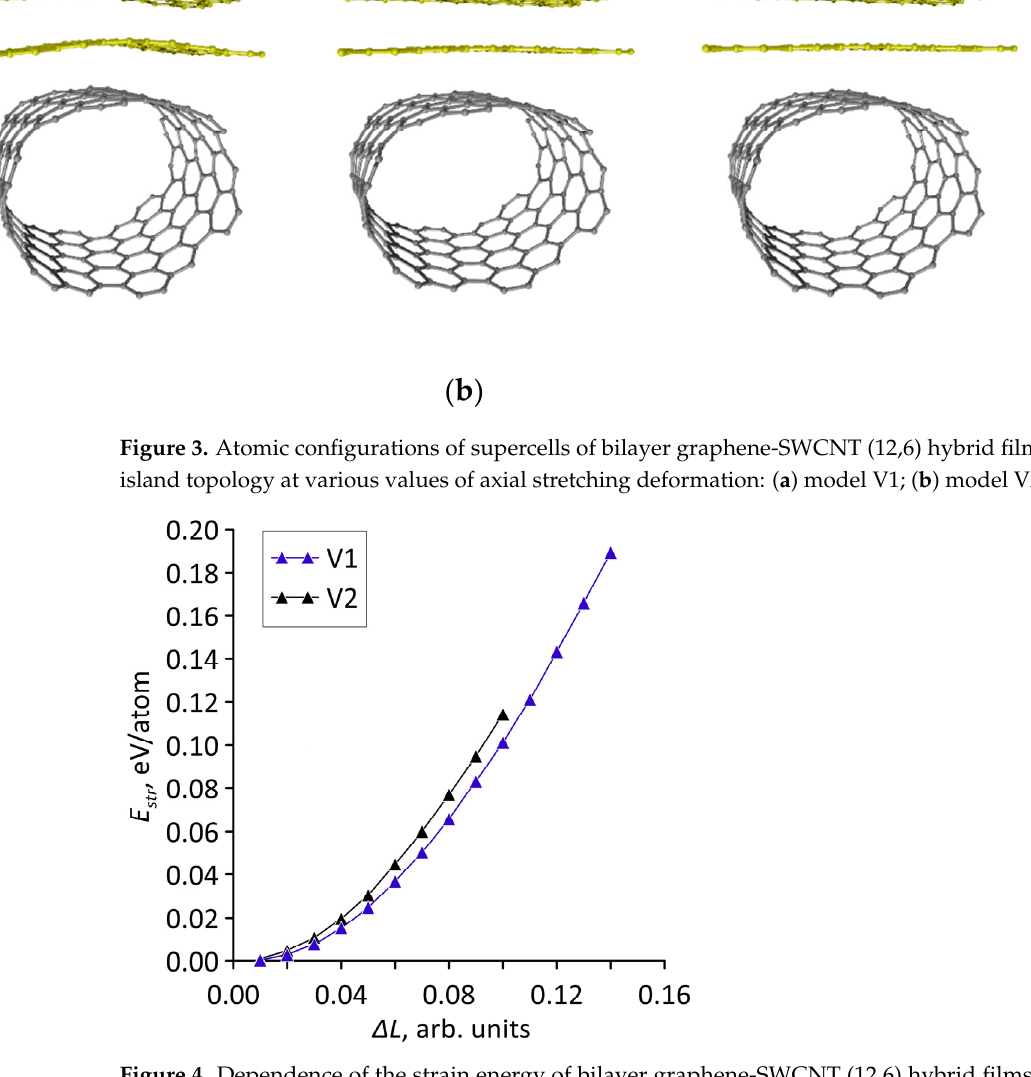
Figure 4. Dependence of the strain energy of bilayer graphene-SW С NT (12,6) hybrid fi lms on the magnitude of stretching in relative units for supercells of topological models V1 and V2.